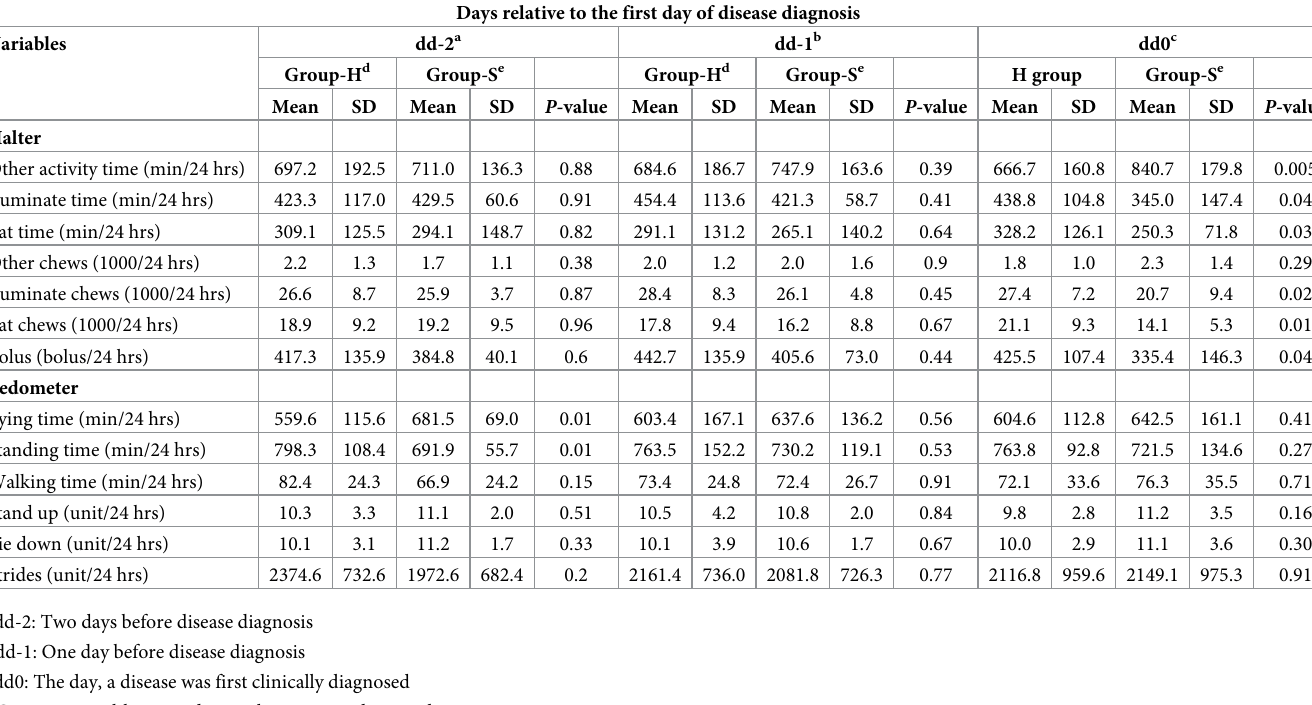
Table 4. Mean values of variables of RumiWatch 1 halters and pedometers of group-H and group-S cows at dd0, dd-1, and dd-2. Days relative to the first day of disease